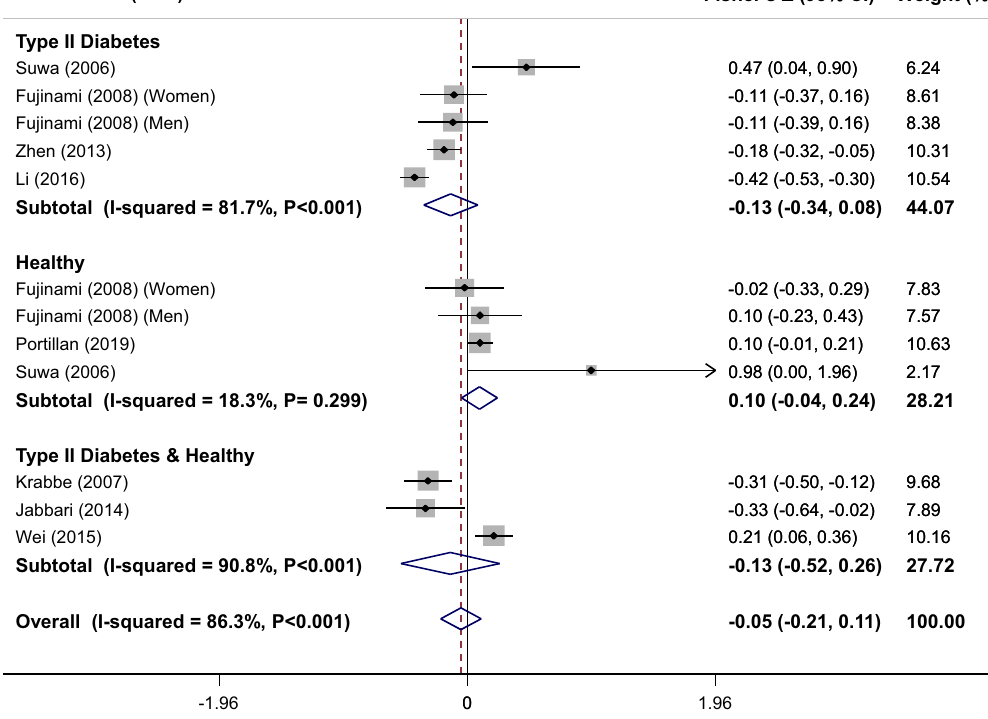
Overall (I-squared = 86.3%, P<0.001)